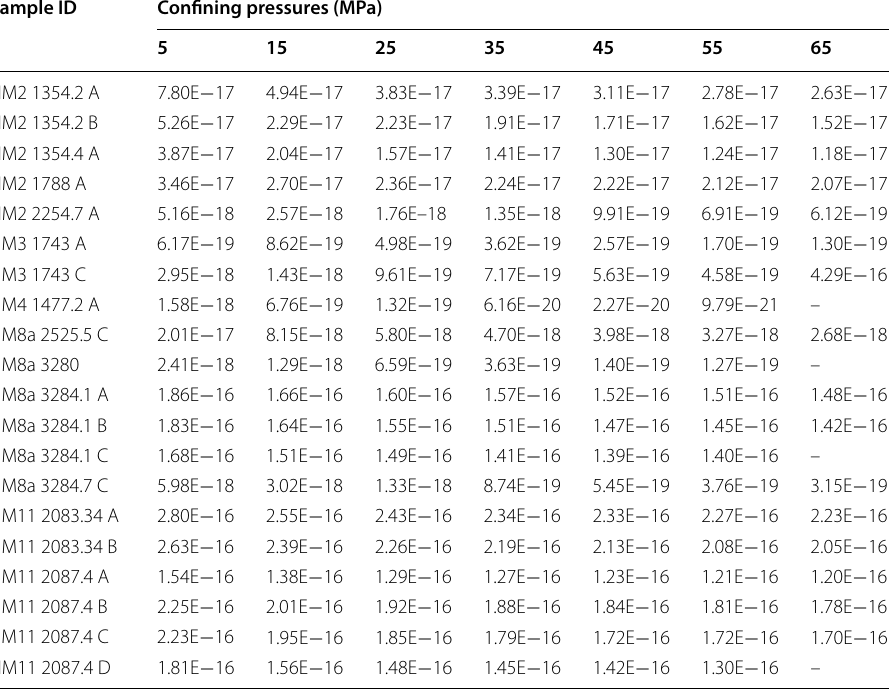
Table 7 True permeability at confining pressures from 5 to 65 MPa using Klinkenberg